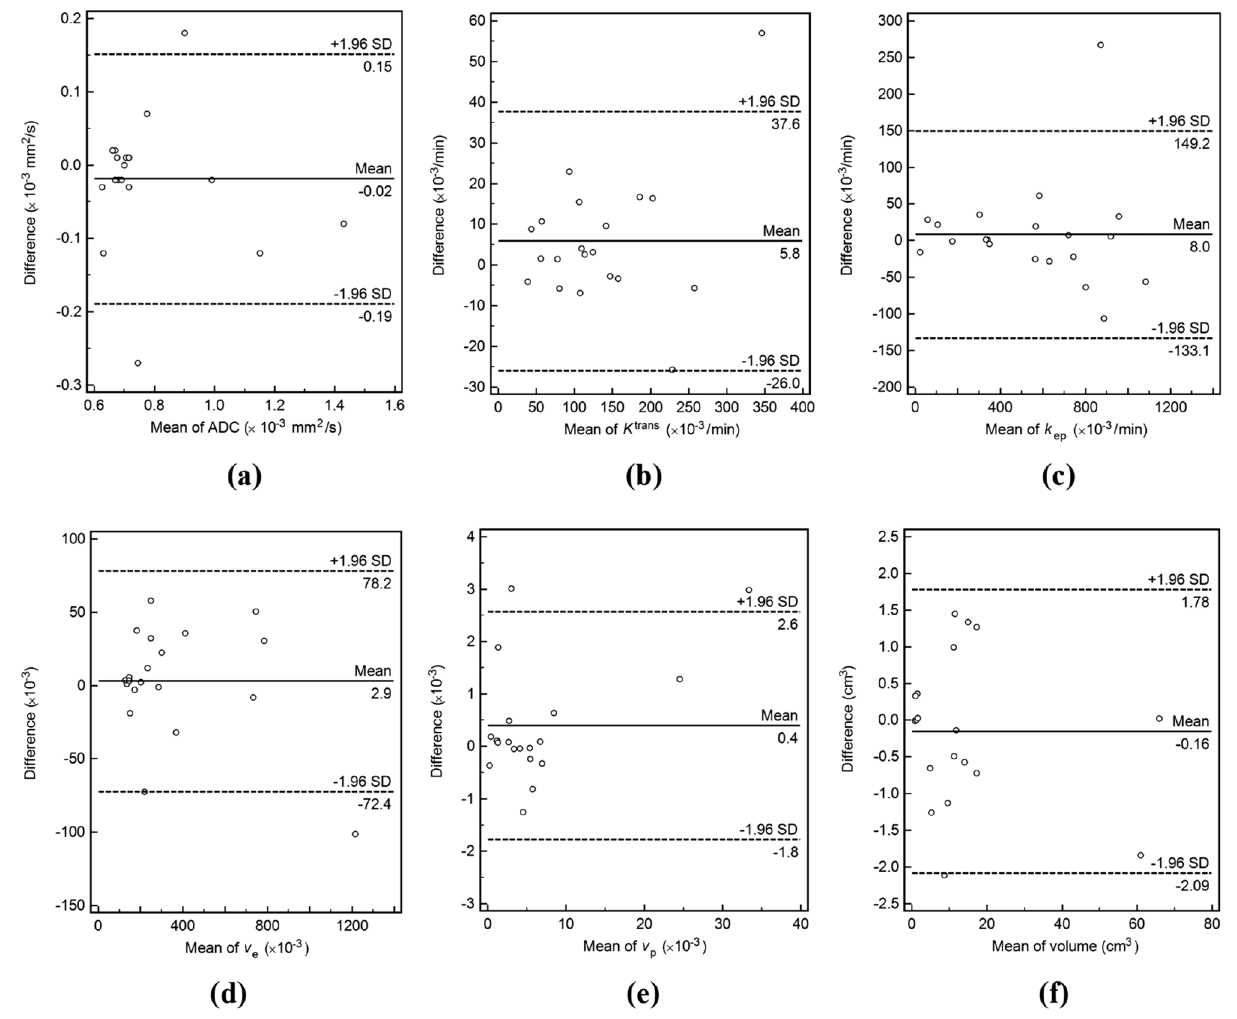
Figure 2. Bland–Altman plots of ( a ) ADC, ( b ) K trans , ( c ) k ep , ( d ) v e , ( e ) v p , and ( f ) tumor volume demonstrating agreement between the values measured by the two readers. The difference ( y -axis) between the measurements obtained by the two readers is plotted against the mean value ( x -axis) of the measurements obtained by them. The solid line and the top and bottom dashed lines indicate the mean difference and the upper and lower margins of 95% limits of agreement, respectively. ADC, apparent diffusion coefficient; K trans , volume transfer constant; k ep , rate constant; v e , volume fraction of the extravascular extracellular matrix; v p , blood plasma volume; SD, standard deviation.